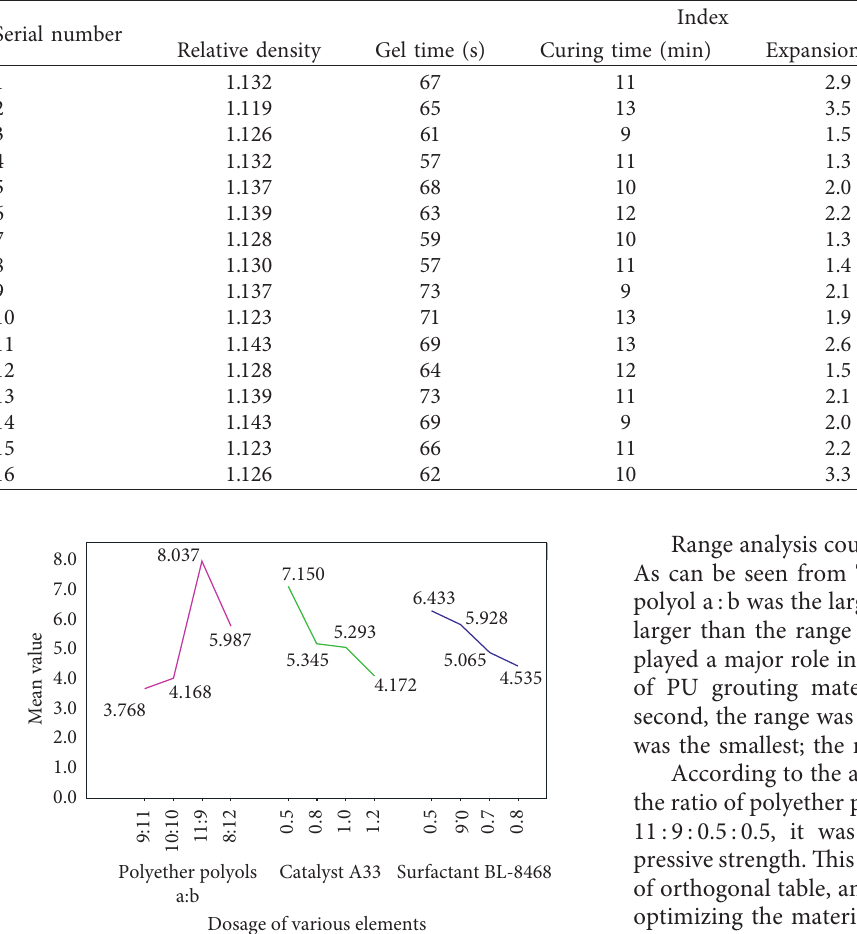
Table 3: Basic performance index of materials.